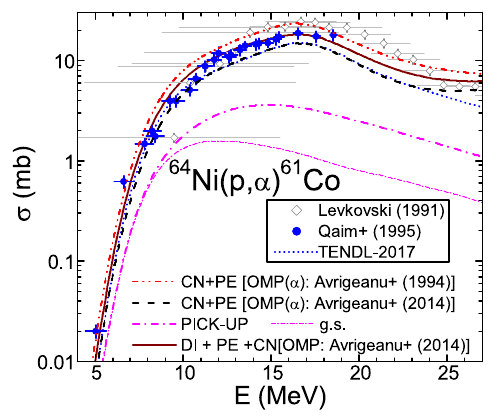
Figure 3. As Fig. 1 but for 64 Ni( p ,α ) 61 Co reaction, except addi- tional g.s. (thin dash-dotted) and total (dash-dotted) DI compo- nents of total cross sections (solid).